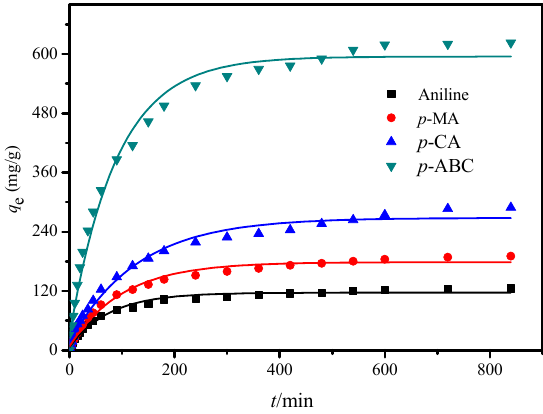
Figure 8. Adsorption kinetics of anilines on the CDM-HCP.